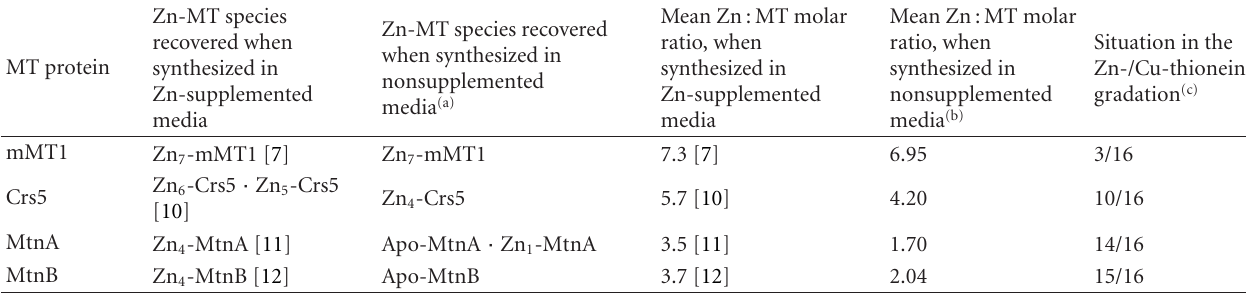
Table 3: Comparison of the Zn-MT complexes recovered from recombinant syntheses in Zn- and nonsupplemented culture media. Zn-MT MT protein